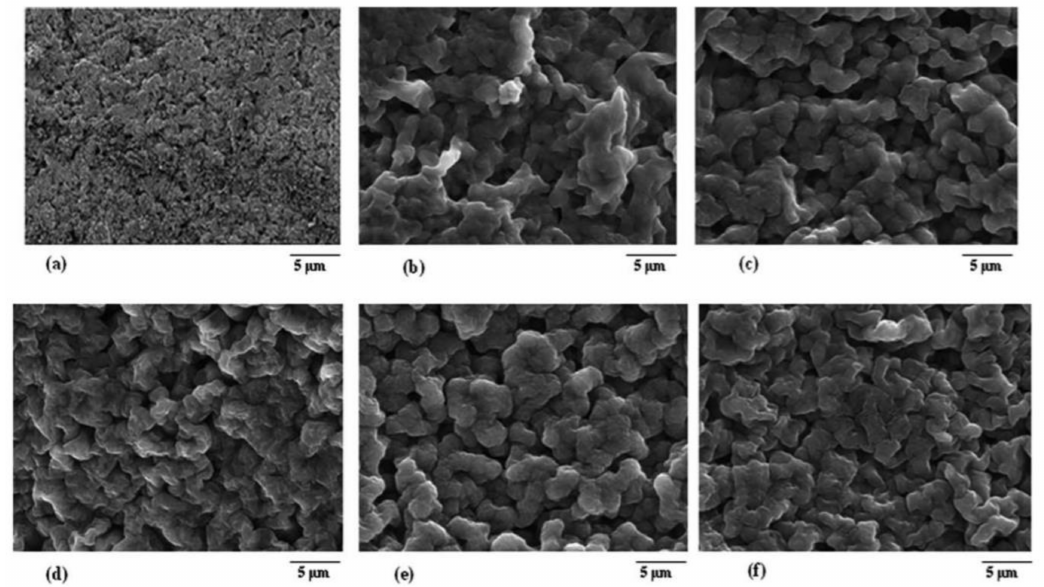
Figure 4. FESEM images of pure ( a ) PVdF-co-HFP film and nanocomposite GPE films containing ( b ) 0 wt %, ( c ) 6 wt % Al 2 O 3 , ( d ) 30 wt % Al 2 O 3 , ( e ) 6 wt % MgAl 2 O 4 , and ( f ) 20 wt % MgAl 2 O 4 . Reproduced with permission from